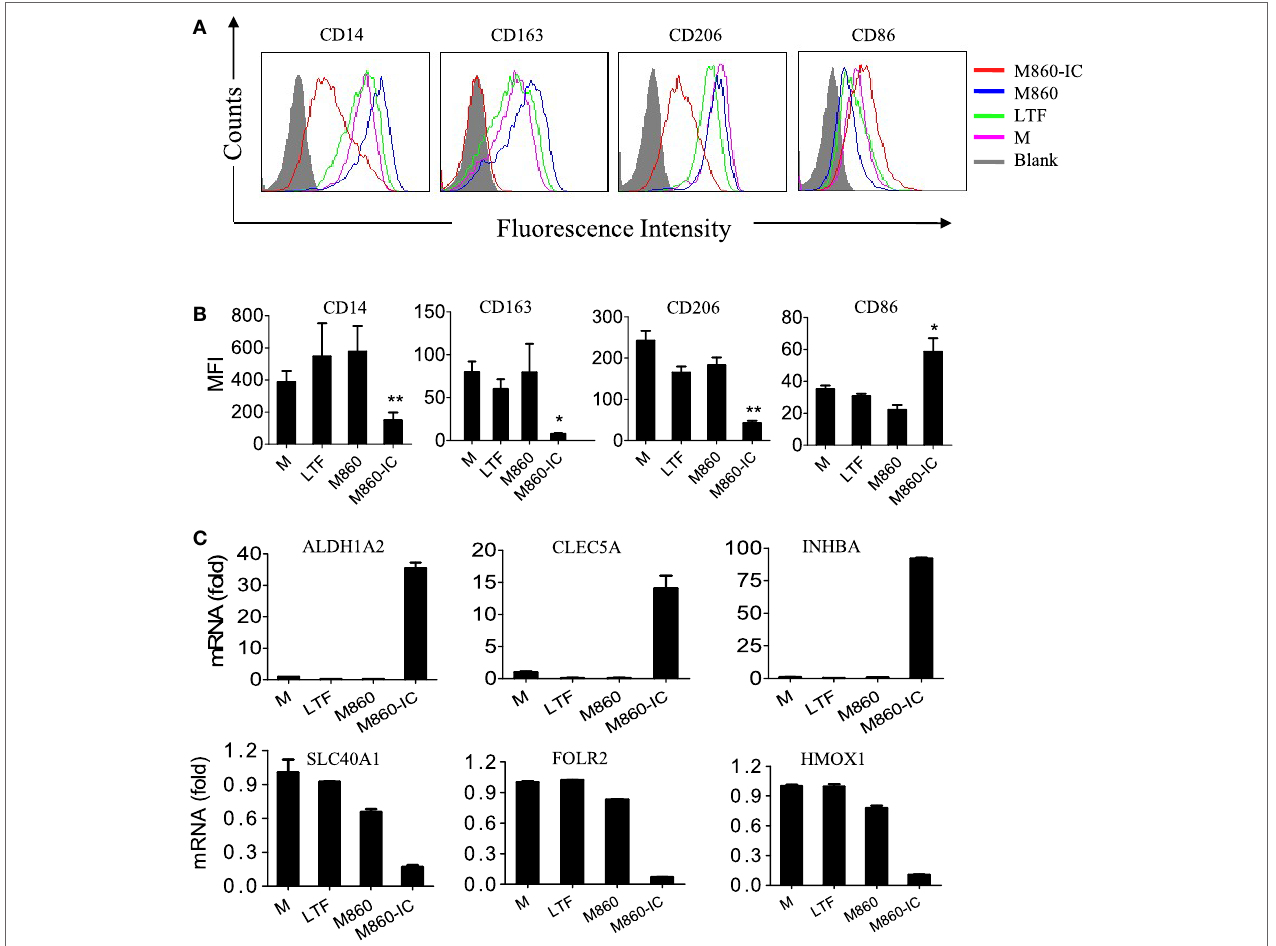
FigUre 3 | Effects ofM860-ICon human macrophage polarization. (a) (M-CSF)-M2 macrophages were stimulated with, or without (M), 30 µg/ml lactoferrin (LTF), M860, M860-IC for 18 h, then the collected cells were stained with APC-conjugated anti-human CD14, APC-conjugated anti-human CD163, PE-conjugated anti-human CD206, or CD86 for flow cytometric analysis. Mean fluorescence intensity were analyzed in (b) of three independent experiments (b) . (c) (M-CSF)-M2 macrophages were stimulated with 10 µg/ml LTF, M860, and M860-IC for 18 h, then the collected cells were analyzed for mRNA expression of M1-specific markers including SLC40A1, FOLR2, and HMOX1, and M2-specific markers including ALDH1A2, CLEC5A, and INHBA (normalized to GAPDH expression, fold increase compared with unstimulated controls) by quantitative RT-PCR. The results are representative of three experiments from different